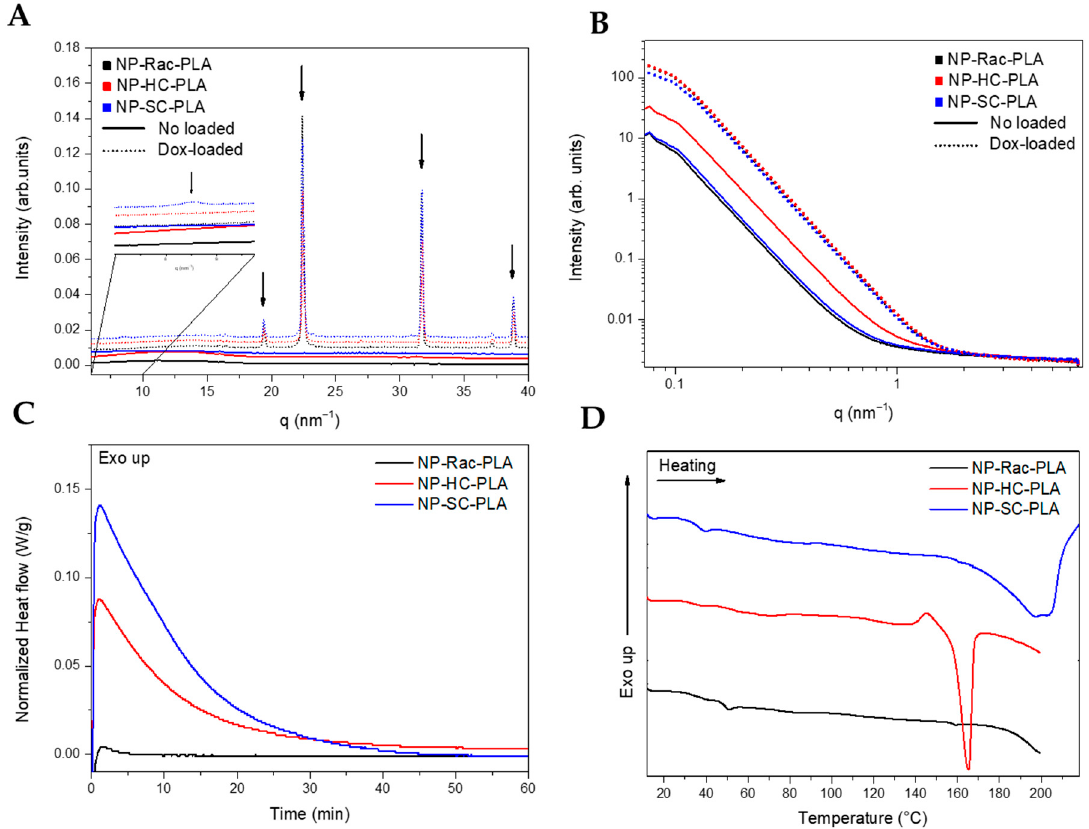
Figure 4. WAXS ( A ) and SAXS ( B ) of the different PLA nanoparticles. DSC thermograms of the nanoparticles during the isothermal step at 65 °C ( C ) and subsequent heating ( D ).